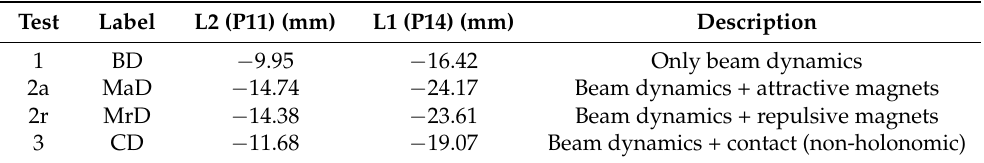
Table 4. Tests carried out during experimental campaign.